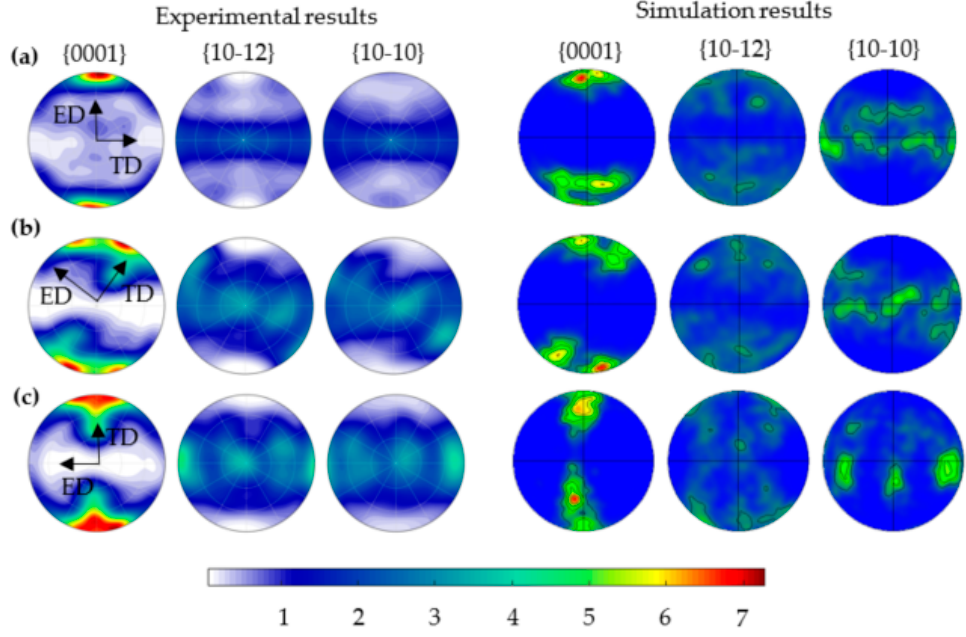
Figure 5. Experimental and Simulation pole figures under uniaxial compression to 8% of ( a ) E0 sample; ( b ) E45 sample; ( c ) E90 sample.